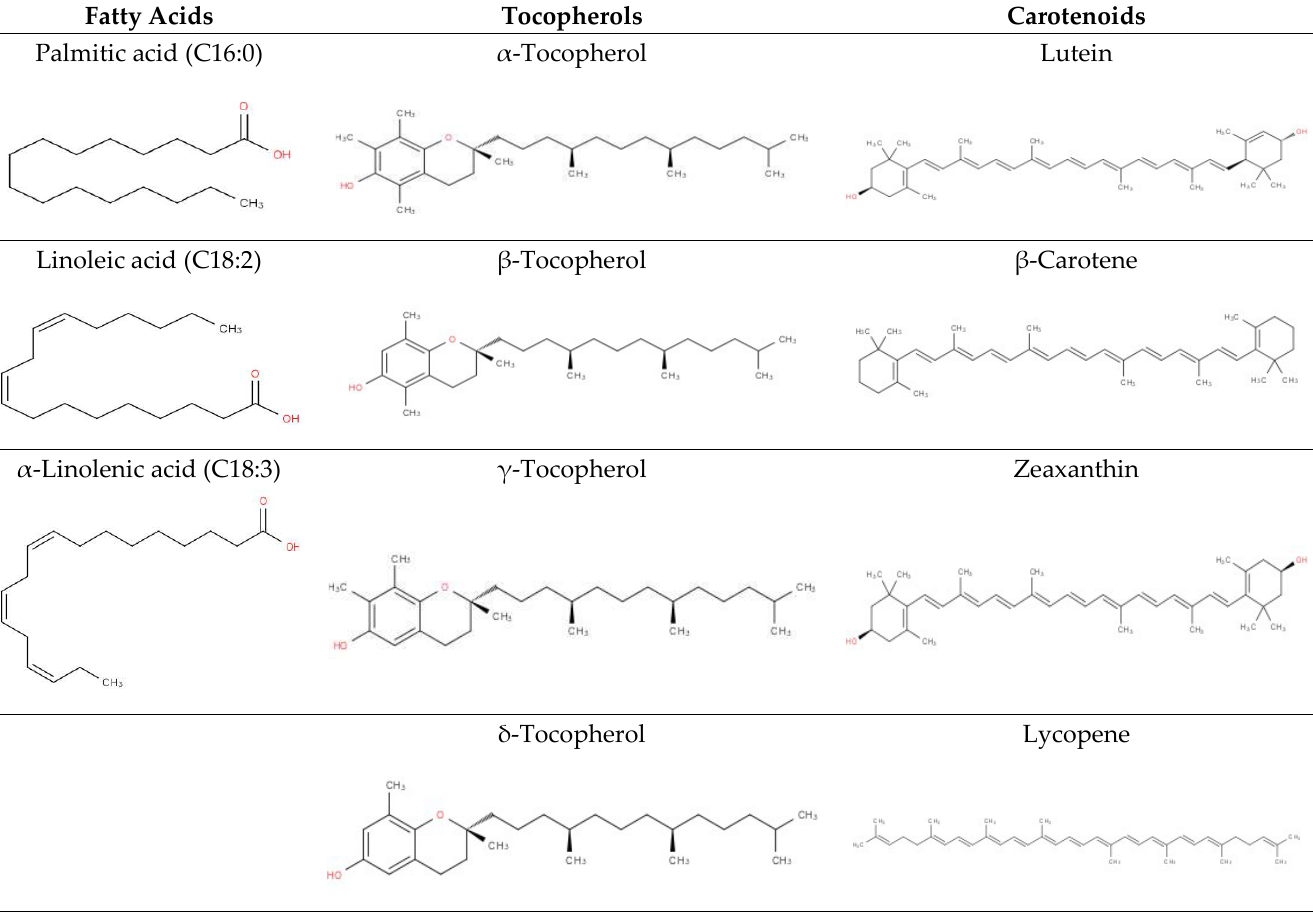
Figure 2. Chemical structures of the main lipophilic compounds detected in edible flowers. Source: Hastings, et al.